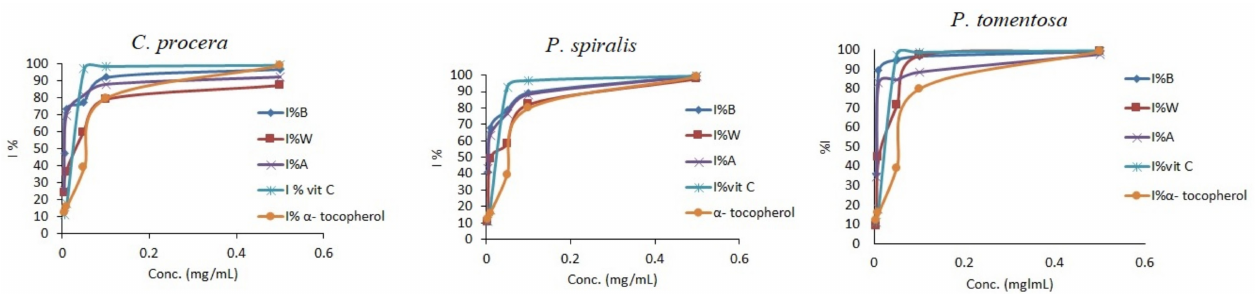
Figure 3. Antioxidant activity of crude extracts from C. procera , P. spiralis , and P. tomentosa and standards using the ABTS method. B = butanol extract, A = aq. MeOH extract, W = water